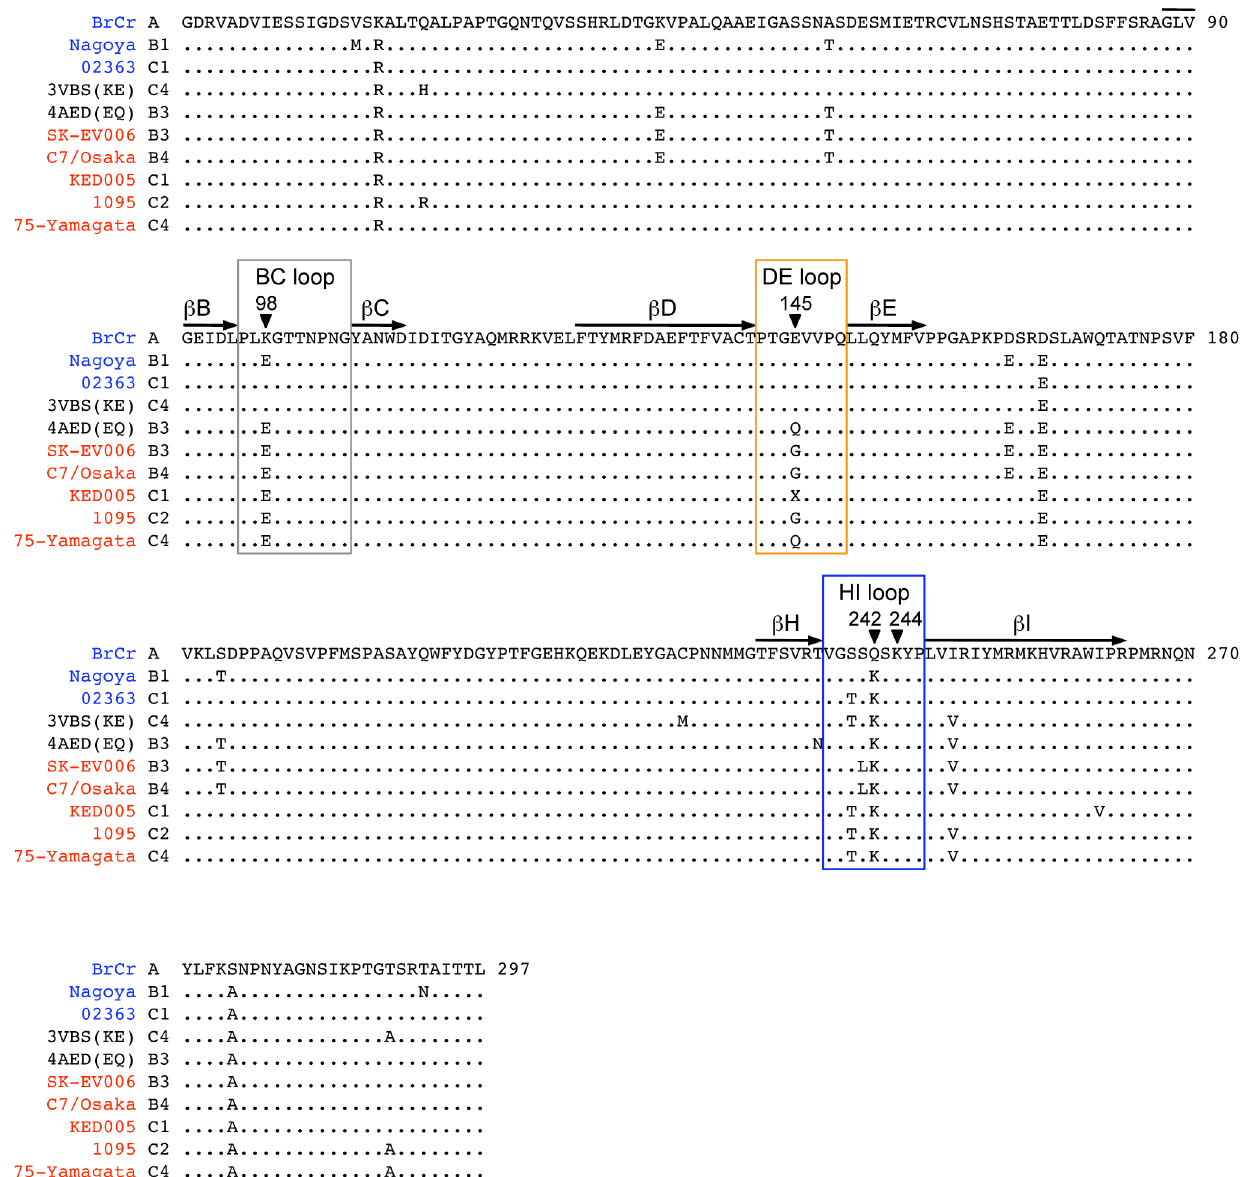
Figure 4. Alignment of EV71 VP1 sequences. The names of the EV71-PB and EV71-non-PB strains are in red and blue, respectively. 4AED (EV71- EQ) and 3VBS (EV71-KE) in black are presumably PB and non-PB viruses, respectively. The names are followed by their subgenogroups. The BC, DE, and HI loops (boxed) and the b barrels (shown with arrows) are defined as in reference 4. The amino acids where mutations were introduced are indicated by arrowheads. The conserved amino acids are shown with dots. The amino acid at VP1-145 (X) of EV71-KED005 could not be determined because there was a mixture of sequences at his position.